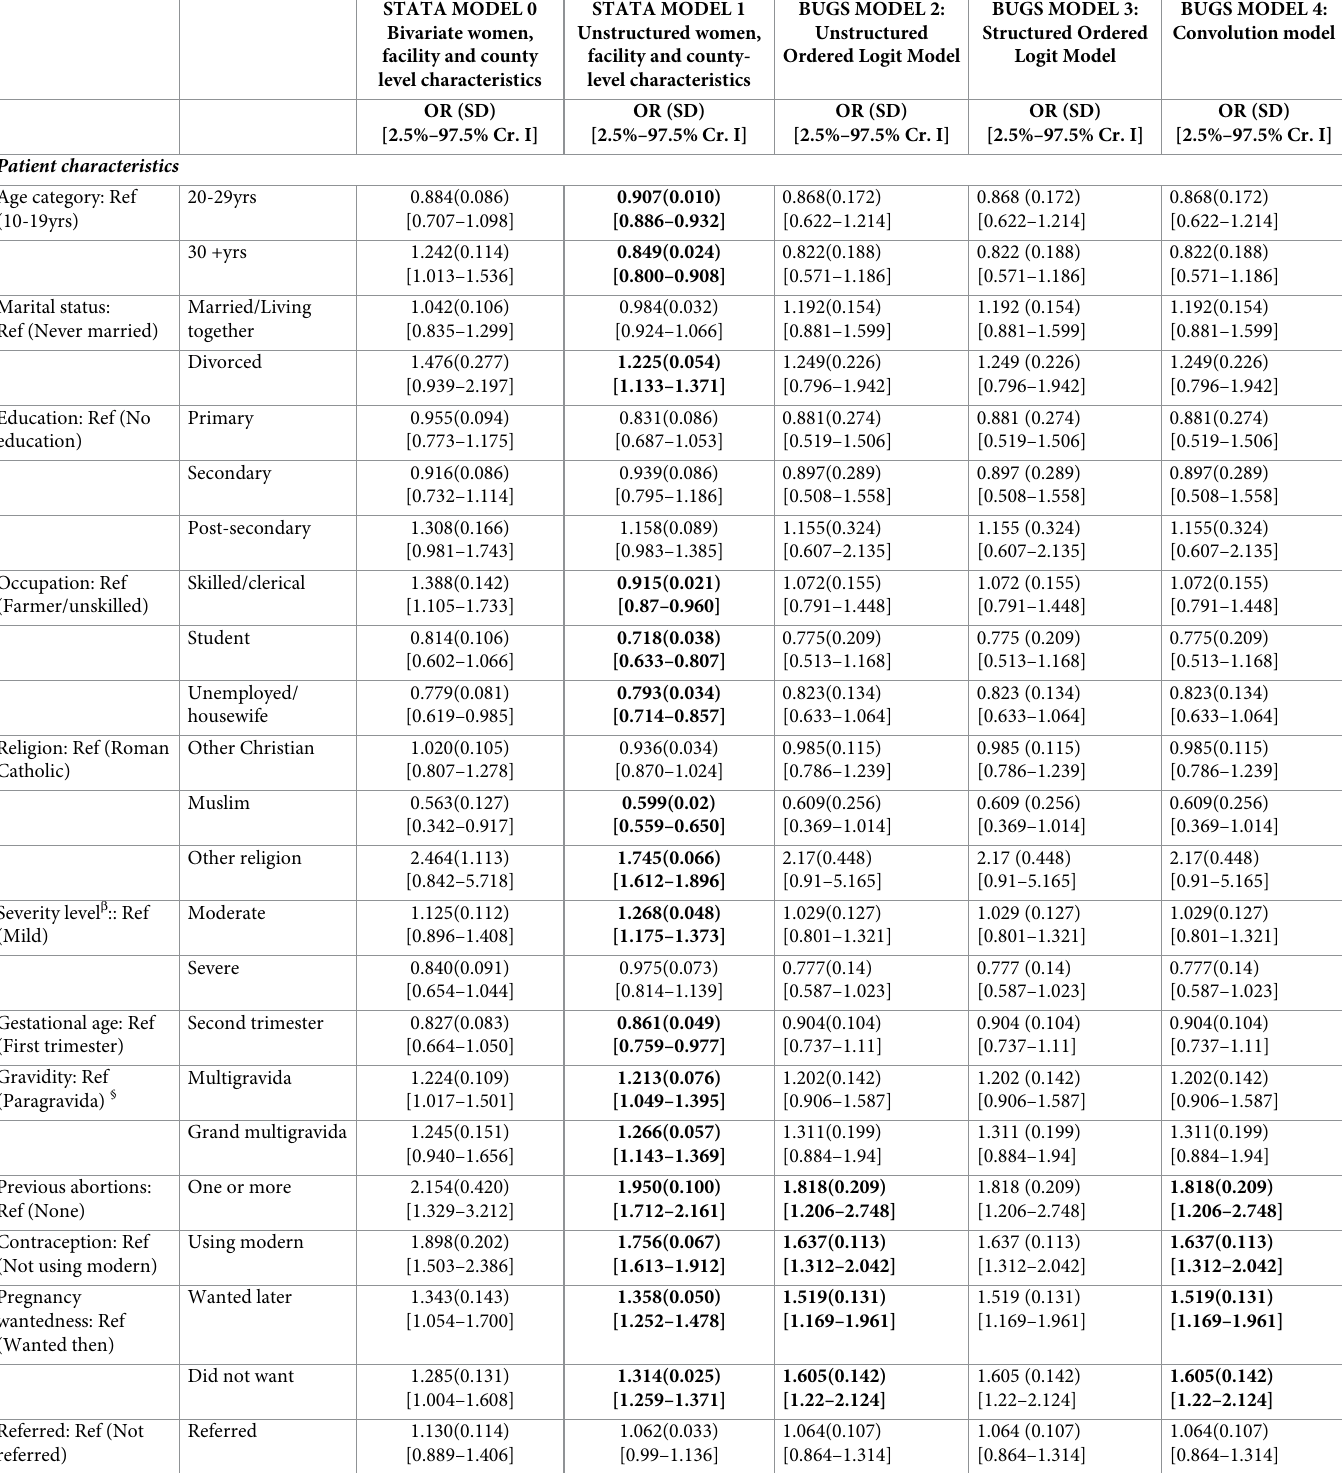
Table 4. Mixed-effects odds of PAC patients adopting a highly effective contraceptive method in healthcare facilities in